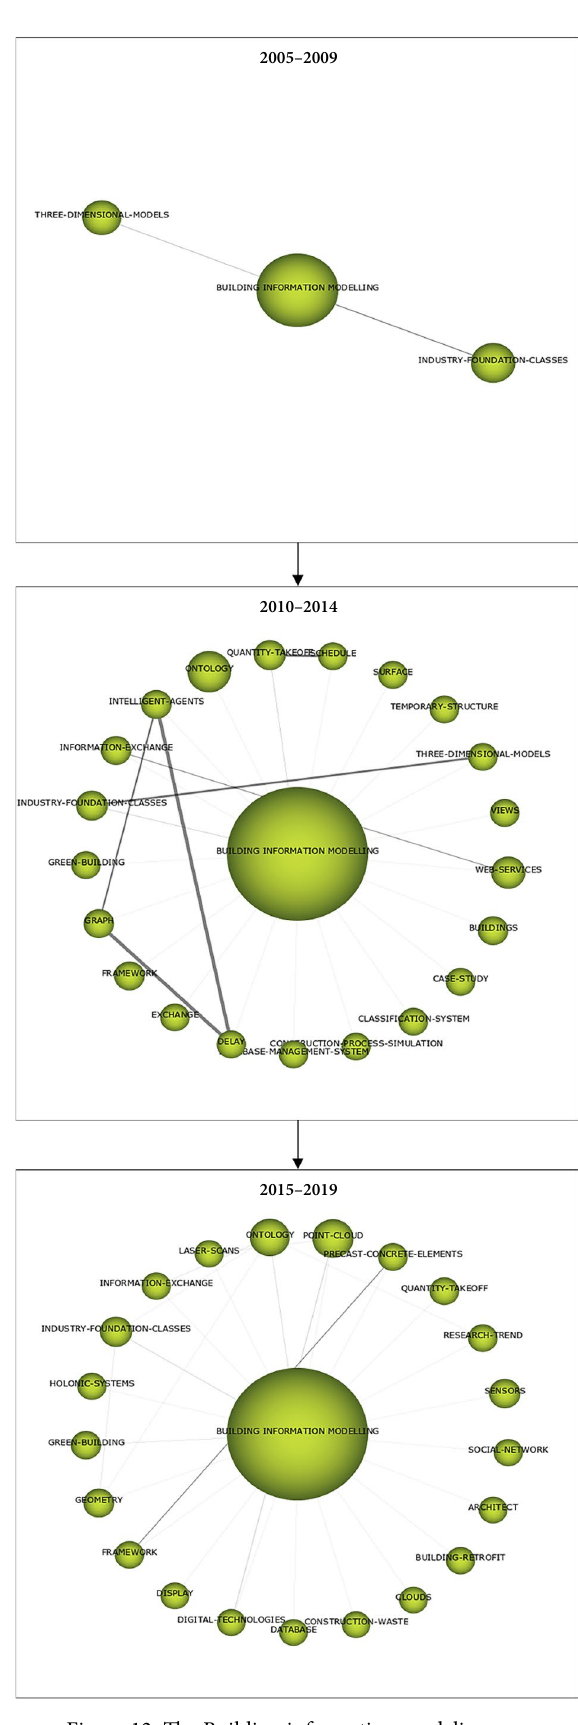
Figure 11. The thematic evolution of AutCon publications Figure 12. The Building information modeling